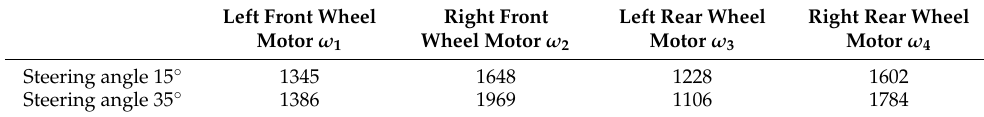
Table 3. Differential speed of each drive motor when the loader is empty (4 km/h) (unit: rpm).